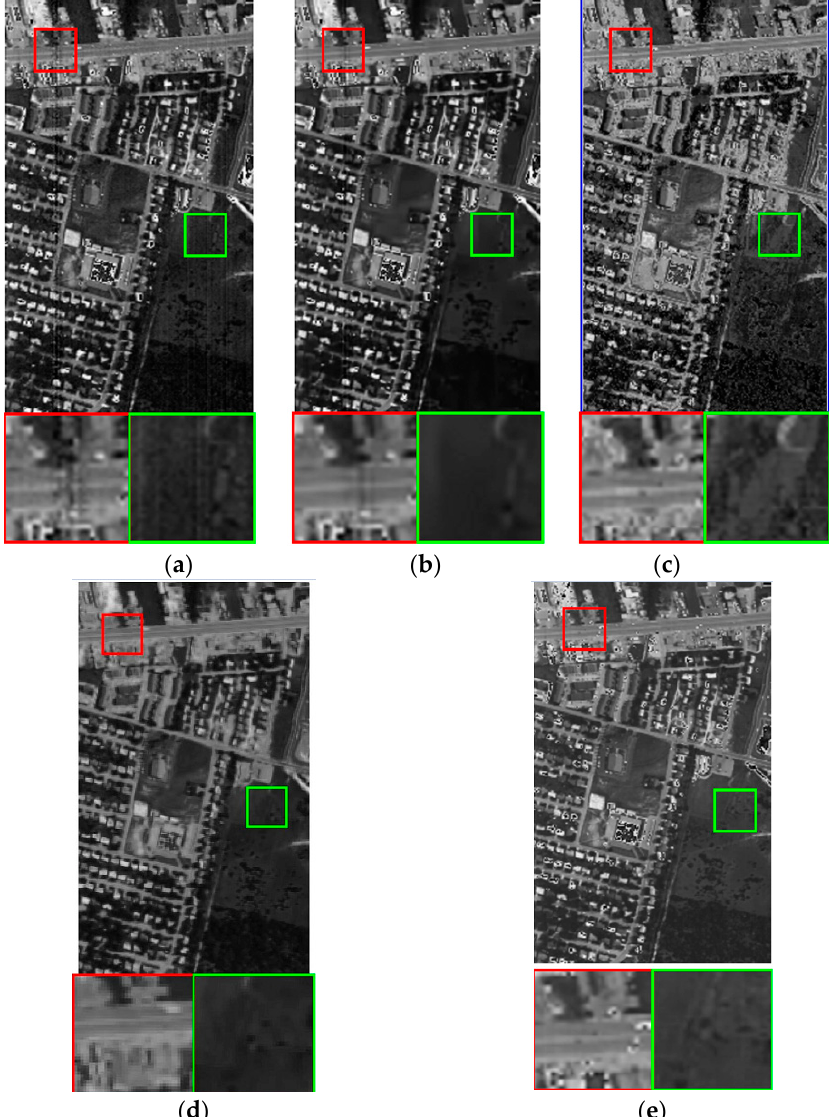
Figure 10. Visual results on band 2 of urban dataset: ( a ) Captured actual band, ( b ) Restoration results of VBM3D based method, ( c ) Restoration results of Godec based method, ( d ) Restoration results of SLrank based method, ( e ) Restoration results of the proposed method.